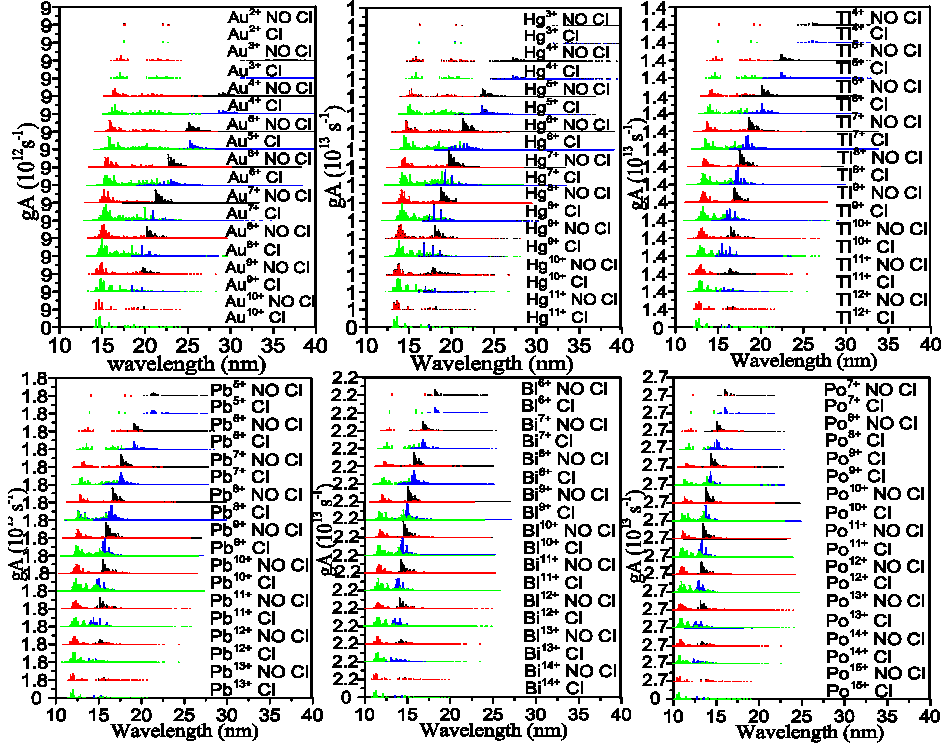
Figure 1. (Color online) Ir-like through Tm-like spectra of Au-Po calculated with the Cowan Code both including Configuration interaction (CI) (green denotes 5p − 5d and blue denotes 5d − 5f ) and excluding CI (red denotes 5p − 5d and black denotes 5d − 5f ).